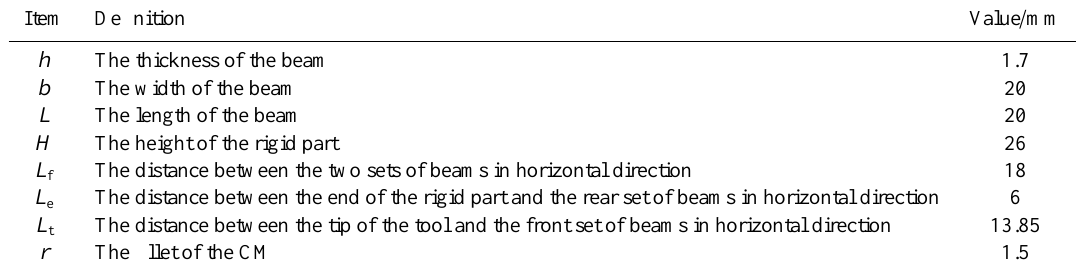
Table 1. Critical dimensions of the CM.